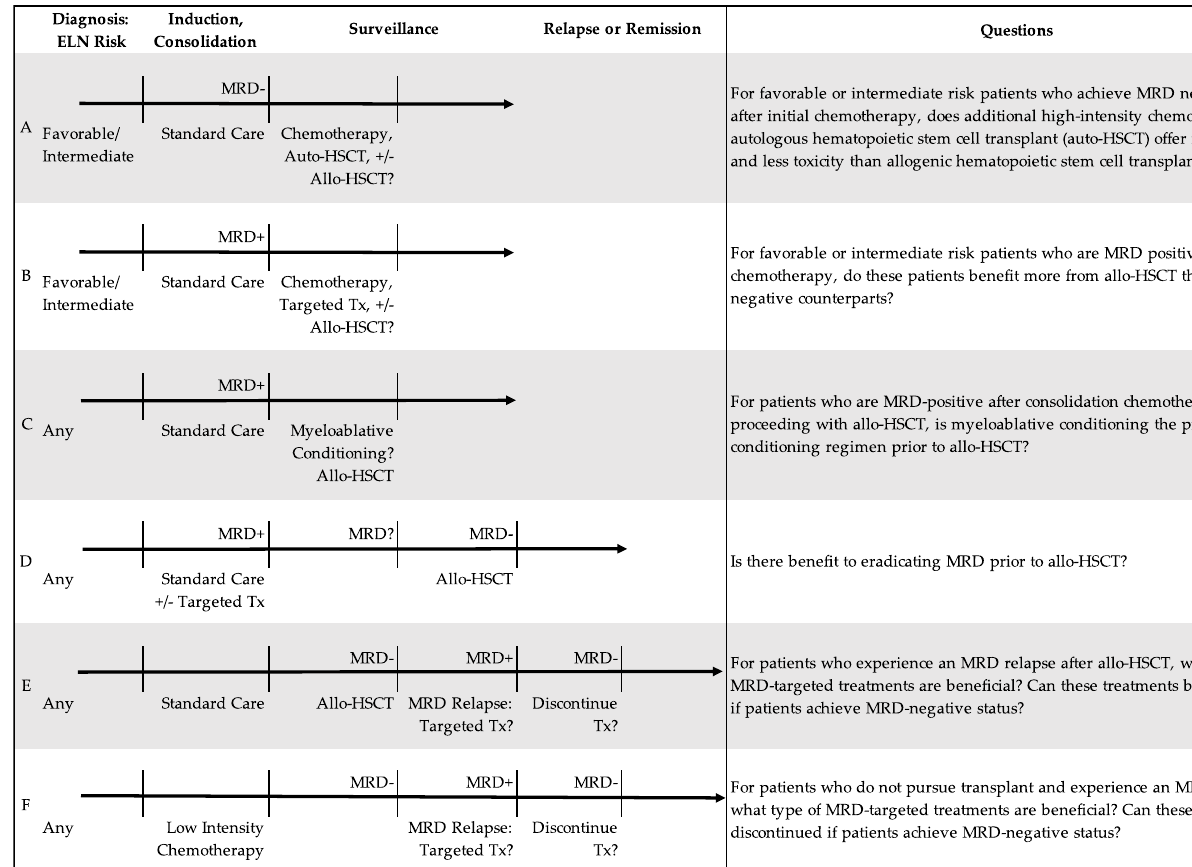
Figure 2. Six scenarios of AML treatment based on European LeukemiaNet (ELN) risk category and measurable residual disease (MRD) status. ELN risk categories are noted in the first column [3]. MRD status is first established after achieving remission and up to two cycles of chemotherapy, as defined in the ELN consensus 2021 update [10]. As the most significant timepoint of MRD-negative state in relation to treatment administered remains unknown, we show MRD status after initial induction and/or consolidation chemotherapy. Abbreviations: measurable residual disease positive